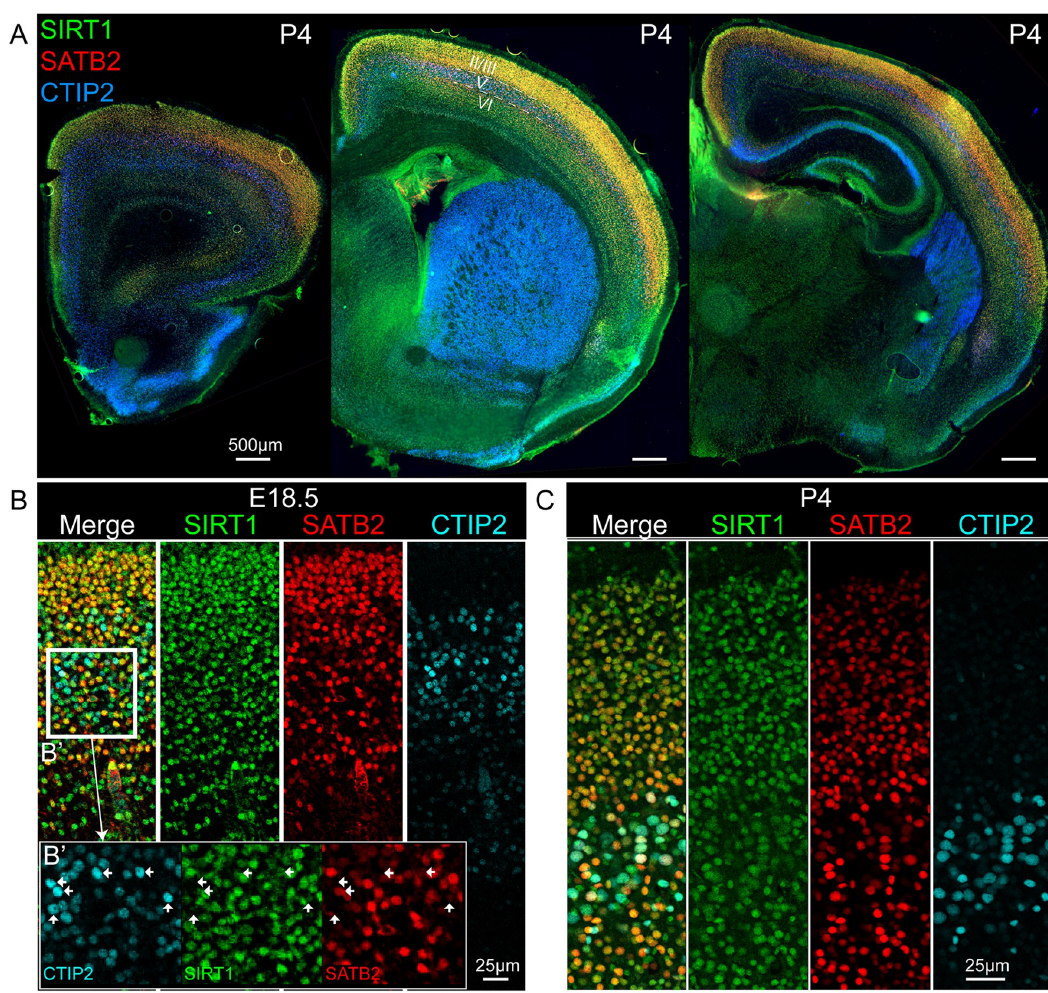
Fig 4. SIRT1 was differentially expressed by CPN and SCPN/CSN in vivo . (A) At P4, immunocytochemical labeling showed that SIRT1 was expressed along the entire rostral-caudal extent of the neocortex, in layers II/III, VI, and subplate (50 micrometer coronal section, wide-field fluorescence imaging). (B) At E18.5, SIRT1 expression in deep layers of motor cortex was predominantly restricted to SATB2-expressing neurons, and was absent or expressed at quite low levels by CTIP2-expressing neurons (50 micrometer coronal section, confocal fluorescence imaging). (C) At P4, SIRT1 expression in deep layers of motor cortex was almost completely restricted to SATB2-expressing neurons (50 micrometer coronal section, confocal fluorescence imaging).